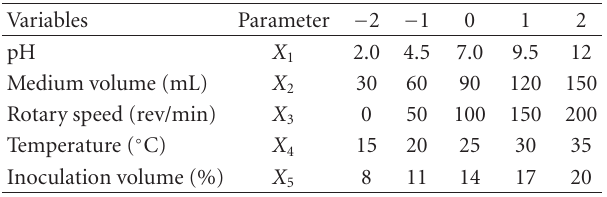
Table 4: Variances and levels of the optimization of strain Hhs.015 T fermentation conditions using Response Surface